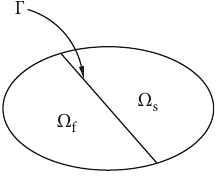
Figure 2: Fluid and solid